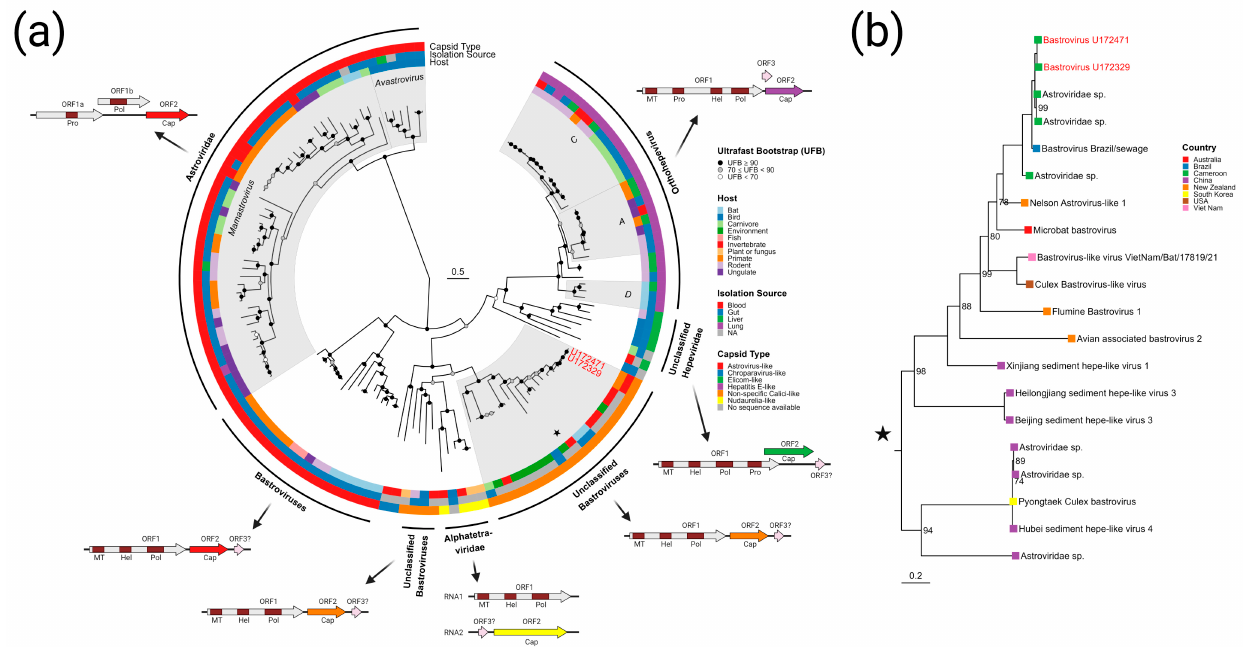
Figure 4. Phylogenetic reconstruction of the Astroviridae, Hepeviridae , and bastroviruses. ( a ) Amino acid ML phylogeny of the RdRp domain from 133 viral isolates. The amino acid sequences were aligned using the L-INS-i algorithm of MAFFT and the Q.pfam+F+R6 substitution model was selected by IQ-TREE 2 as the most appropriate model to reconstruct the phylogeny. Metadata including sampled host, isolation source, and capsid type are shown as rings outside of the tree. Each clade is presented with a representative genomic schematic with domains of interest from each ORF indicated (domain abbreviations: MT—viral methyltransferase; Hel—helicase; Pol—RNA-dependent RNA polymerase; Pro—serine protease; Cap—capsid). The clade of interest containing the viruses isolated in this study is denoted by a star. ( b ) An expanded view of the monophyletic group denoted by a star in panel A. Taxa are labeled with isolate name and sampling country. Ultrafast bootstrap support is reported at the